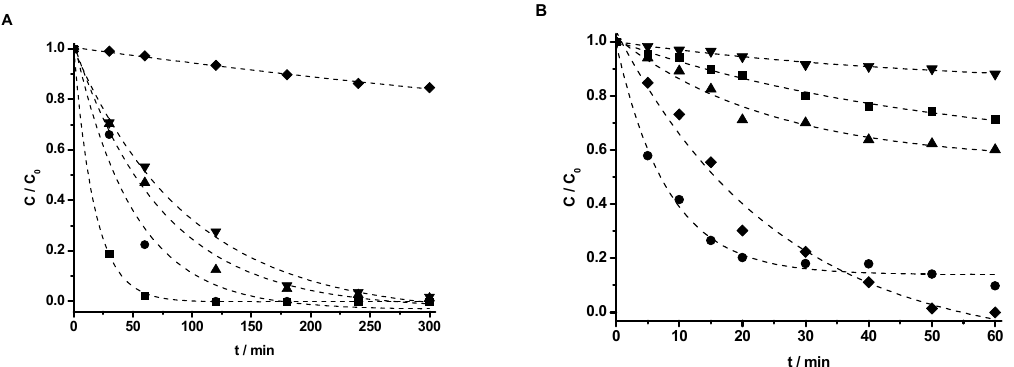
Figure 8. Photodegradation of phenol over Cu(X%)/TiO 2 under (A) Vis ( λ exc > 366 nm) irradiation, (B) UV ( λ exc = 255 nm) irradiation; HPLC–UV detection ( λ = 270 nm). X%: 0% ( ♦ ), 0.1% ( ■ ), 0.3% ( ● ), 0.5% ( ▲ ), 1% ( ▼ ). [Phenol]0 = 50 mg·L –1 , [M(X%)/TiO 2 ]0 = 1.0 g·L –1 , natural pH, T = 298.0 K. Dotted lines show the corresponding first order kinetic fits.